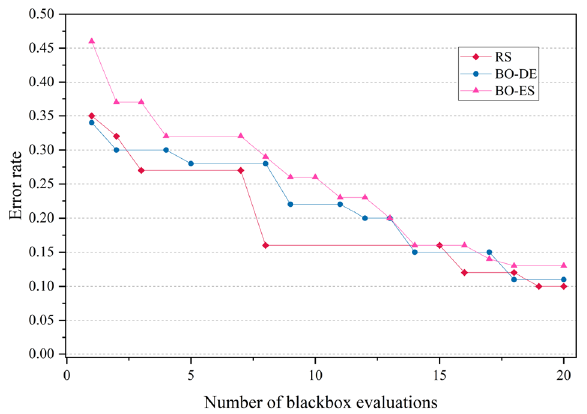
Figure 14. Comparison of how error rates of DenseNet evolve with the number of function evaluations for RS, BO-ES and BO-ES on CIFAR data.